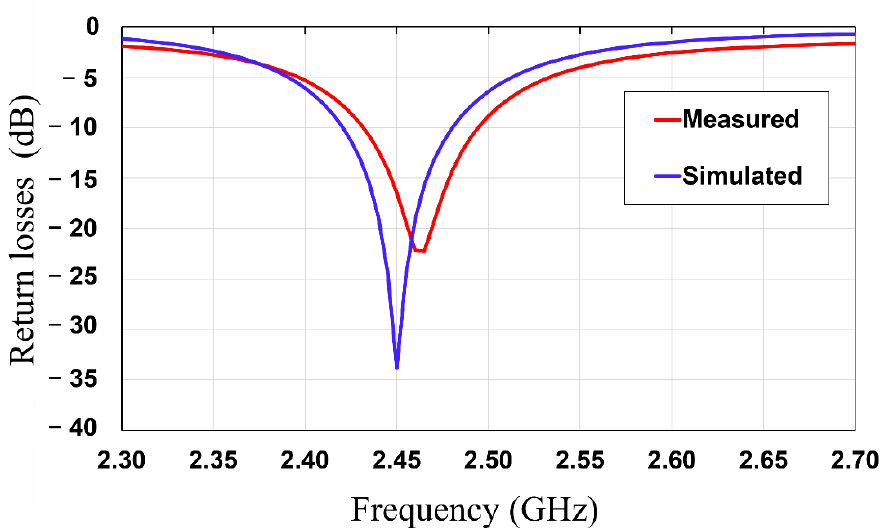
Figure 11. Simulated and measured return loss results of the rectifier circuit.